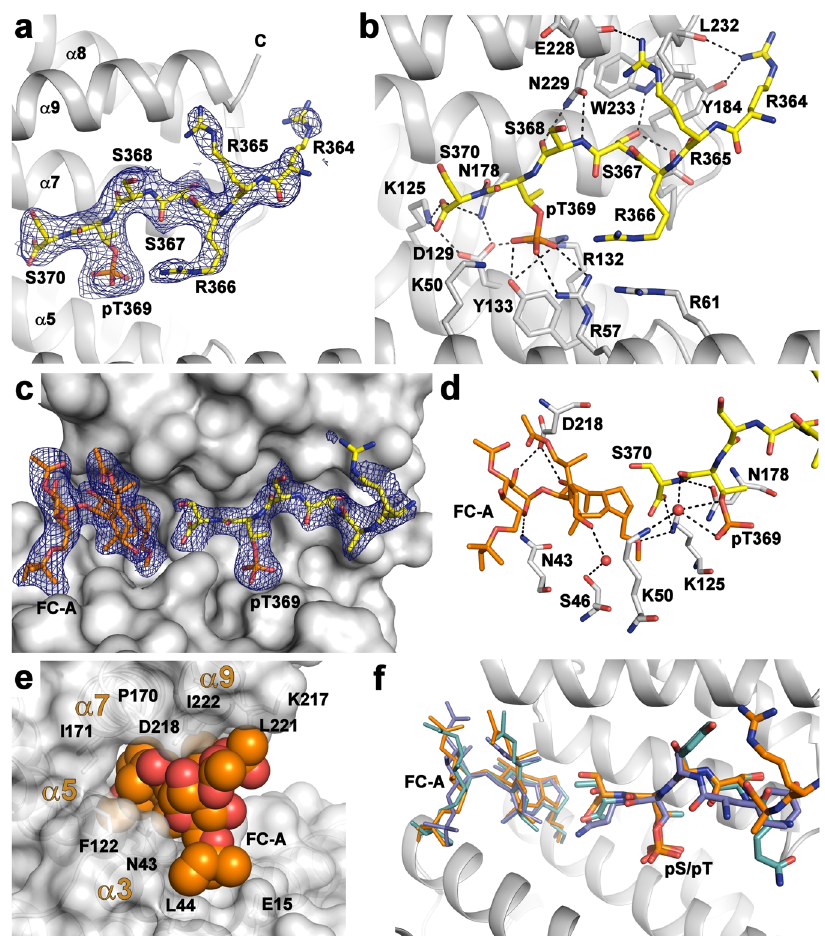
Fig. 2 Structural analysis of interactions between the 14-3-3-binding motif pThr 369 of DAPK2 and 14-3-3 γ . a ctDAPK2-pT 369 peptide (shown as sticks) bound within the binding groove of 14-3-3 γ (shown as ribbon). The fi nal 2 F O − F C electron density map is contoured at 0.8 σ . b Detailed view of contacts between 14-3-3 γ and the ctDAPK2-pT 369 peptide. The DAPK2 residues are shown in yellow, and 14-3-3 γ residues in gray. Polar contacts are indicated by black dotted lines. c FC-A (shown as orange sticks) and the ctDAPK2-pT 369 peptide (shown as yellow sticks) bound within the binding groove of 14-3-3 γ (shown as gray surface). The fi nal 2 F O − F C electron density map is contoured at 1 σ . d Detailed view of polar contacts between the ctDAPK2-pT 369 peptide (yellow sticks) and FC-A (orange sticks). The 14-3-3 γ residues are shown as gray sticks. e Detailed view of interactions between FC-A (orange spheres) and the 14-3-3 ligand-binding groove (gray surface). f Superimposition of the 14-3-3 γ :ctDAPK2-pT 369 :FC-A (orange, this study), 14-3-3:C terminus of the plant plasma membrane H( + )-ATPase:FC-A (cyan, PDB ID: 1O9F) and 14-3-3:C terminus of plant KAT1 channel:FC-A (blue, PDB ID: 5NWK) ternary complexes. Only 14-3-3 γ from the 14-3-3 γ :ctDAPK2-pT 369 :FC-A complex is shown for clarity (gray Fig. S5. Furthermore, the speci fi c kinase activity of DAPK2 RNTD (31.3 ± 0.2 nmol min − 1 mg − 1 , measured using the peptide con- taining the N-terminal part of the Myosin regulatory light chain, sequence KKRAARATSNVFA, as the substrate) was also similar to that of DAPK2 WT (30.9 ± 0.3 nmol min − 1 mg − 1 ) (Supple- mentary Fig. S6a). In line with previous reports, the kinase activity of DAPK2 RNTD decreased signi fi cantly in the presence of 14-3-3 proteins (Supplementary Fig. S6b) 25,26 . Hence, we used DAPK2 RNTD for the biophysical and structural characterization of interactions between DAPK2 and 14-3-3 γ .